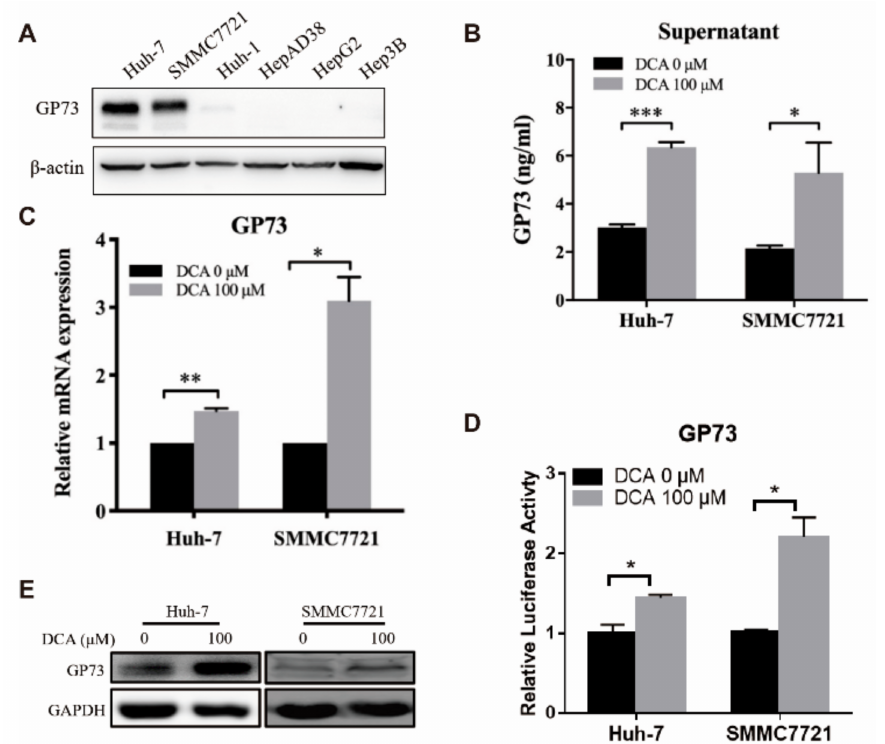
Figure 2. Deoxycholic acid (DCA) upregulates the expression of endogenous Golgi protein 73 (GP73). ( A ) The basal expressions of GP73 in Huh-7, SMMC7721, Huh-1, HepAD38, HepG2, and Hep3B cell lines were detected by Western blot (WB). Huh-7 and SMMC7721 cells were treated with 100 µ M DCA for 72 h. ( B ) The cell supernatant level of GP73 was determined by ELISA. ( C ) Huh-7 and SMMC7721 cells were treated with or without 100 µ M DCA for 72 h. The messenger RNA (mRNA) levels of GP73 were determined by qRT-PCR. ( D ) Huh-7 and SMMC7721 cells were transfected with PGL3 vector containing promoter of GP73 (PGL3-GP73) and treated with or without 100 µ M DCA. Samples were harvested 48 h after treatment, and luciferase activities were measured. ( E ) Huh-7 and SMMC7721 cells were treated with or without 100 µ M DCA for 72 h. The protein levels of GP73 were determined by WB. Data in B, C, and D are expressed as the mean ± standard error of the mean (SEM) and represent three independent experiments (* p < 0.05; ** p < 0.01; *** p < 0.001; ns: not significant). Statistical analysis was performed using GraphPad